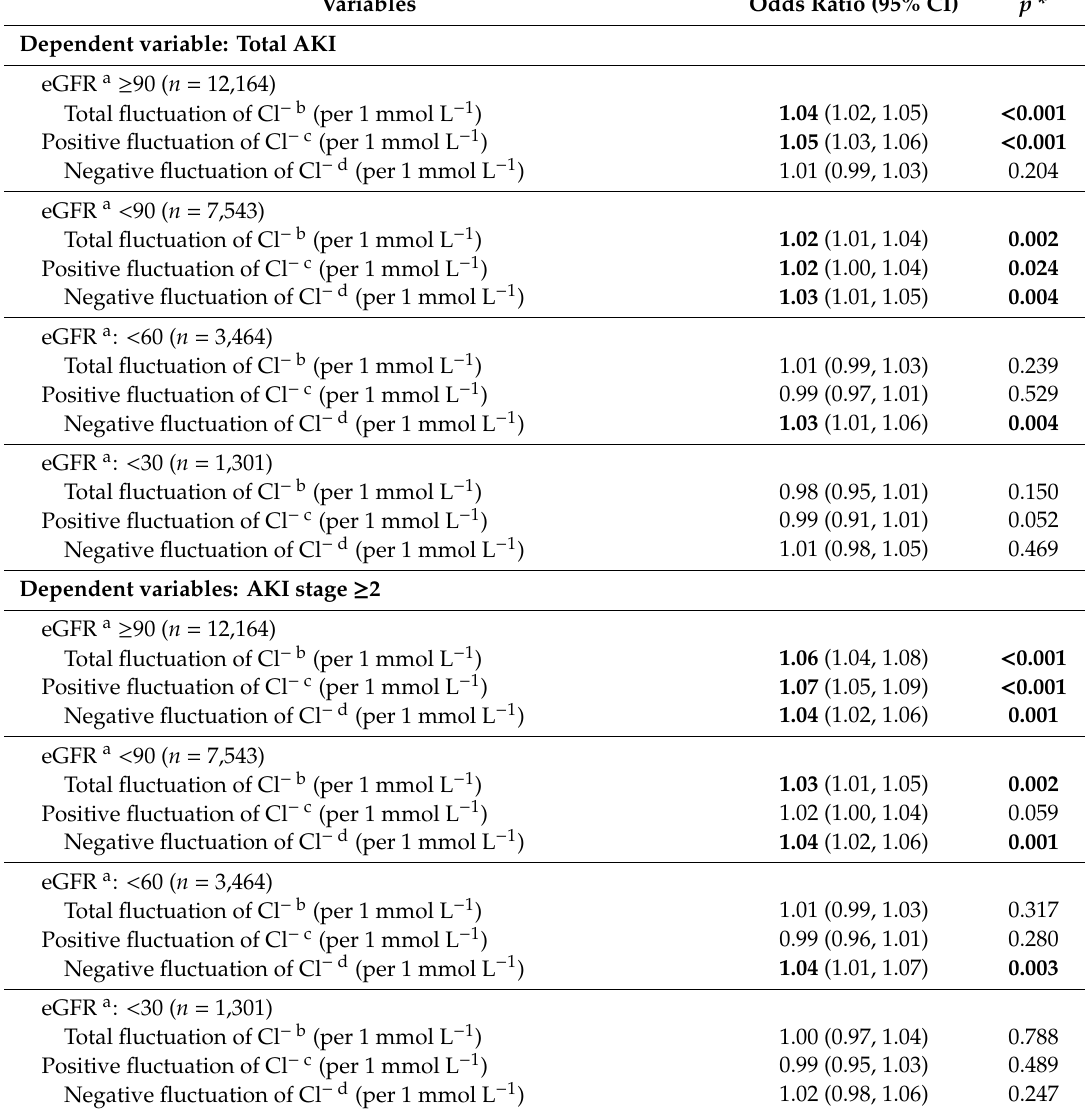
Table 3. Multivariable logistic regression analysis for total AKI and AKI stage ≥ 2 after ICU admission according to preadmission eGFR a